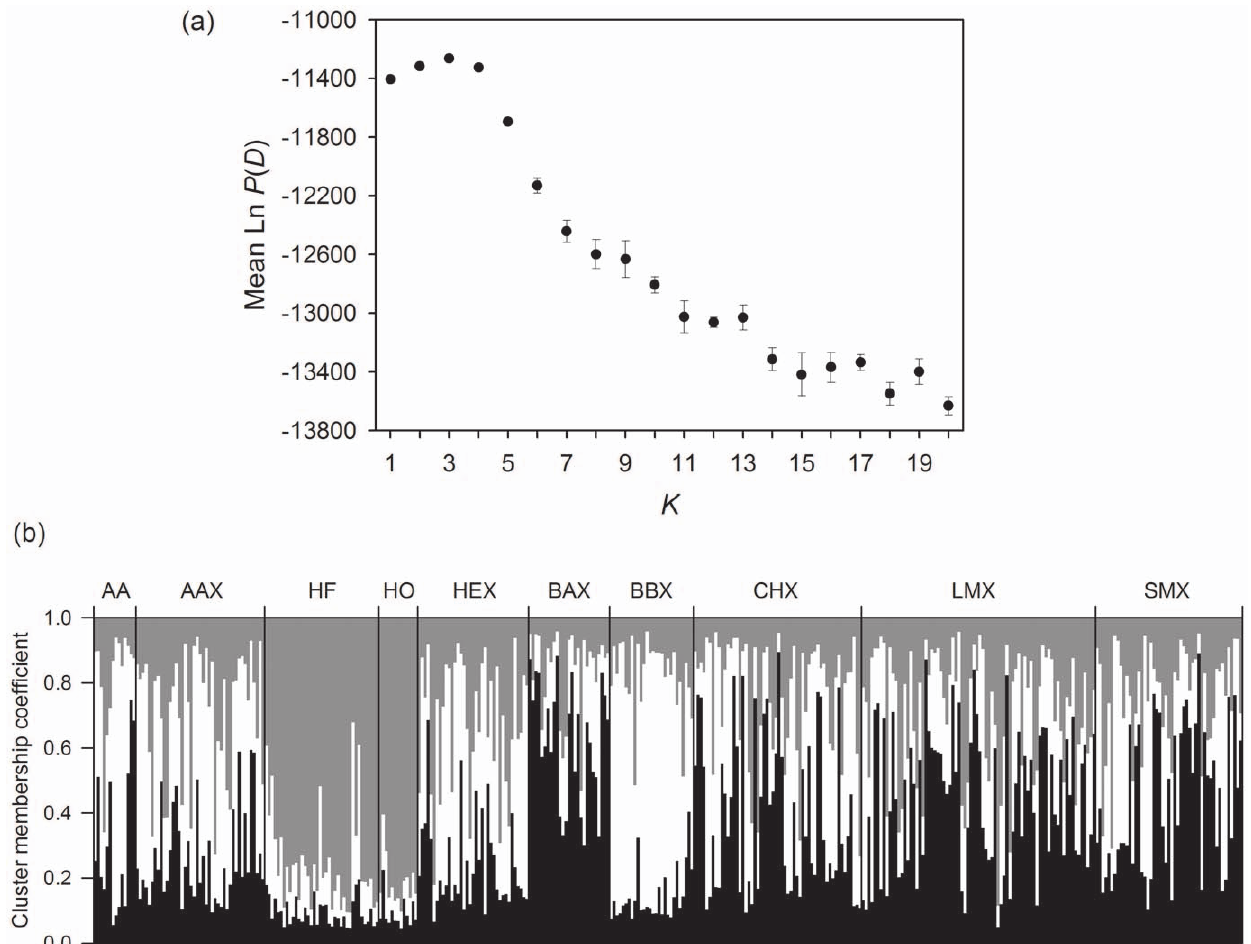
Figure 1. STRUCTURE analysis of cattle sampled in our study. Figure 1a: plot of K values against mean Ln P (D), error bars are 6 1 standard error of the mean. Figure 1b: plot of individual cluster membership coefficients defined by STRUCTURE ( K =3). Breed groups are delineated by vertical black lines and are identified above the figure (AA=Aberdeen Angus, HF=Holstein Friesian, HO=Holstein, HE=Hereford, BA=Blonde D’Aquitaine, BB=Belgian Blue, CH=Charolais, LIM=Limousin, SM=Simmental; in all cases a terminal ‘X’ indicates a cross-breed).